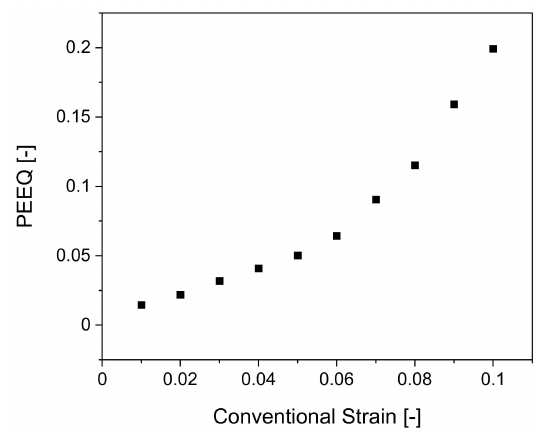
Figure 9. Conventional Strains from tensile tests plotted against equivalent plastic strain (PEEQ) values from simulation for derivation of true strain level introduced by bending.